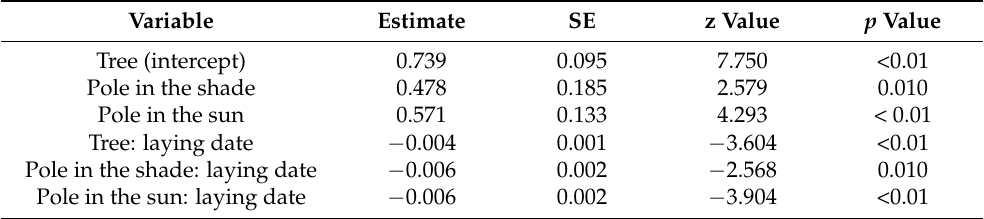
Figure 3. Comparison of the relationship between laying date and the number of nestlings per pair breeding in nest boxes on trees, on poles in the shade, and on poles in the sun, and the mean maximum daily temperature (solid line) from 2012 to 2019 (data from Israel Meteorological Center). Table 2. Aligned rank transform test assessing the effect of nest type and laying date on probability of higher breeding success for laying